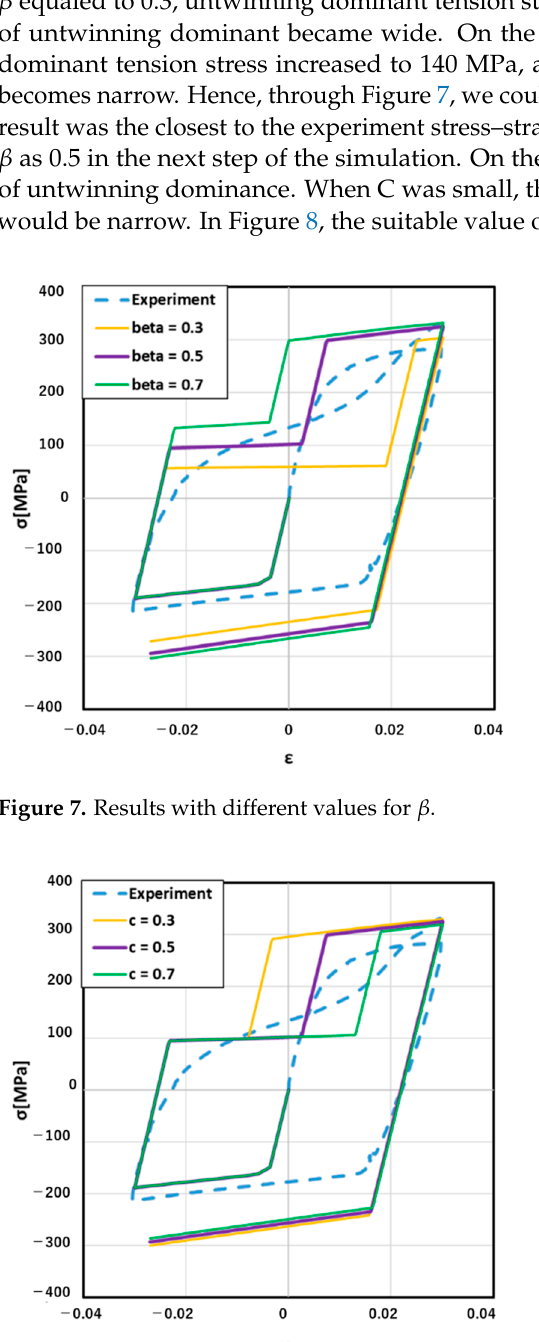
. Figure 9. Input stress–strain (SS) curves for slip deformation and twinning deformation. 4.4. Simulation Results The results of the simulation were evaluated in terms of deformation mode, von Mises effective stress (Figure 10), effective plastic strain (Figure 11) and reaction force vs. stroke curve (Figure 12). The standard model was the model that was optimized by the real shell thickness (1.96 mm) and proper friction coefficient (0.1), and the designed model was that the one employed designed shell thickness (2.00 mm) and friction coefficient (0.2).